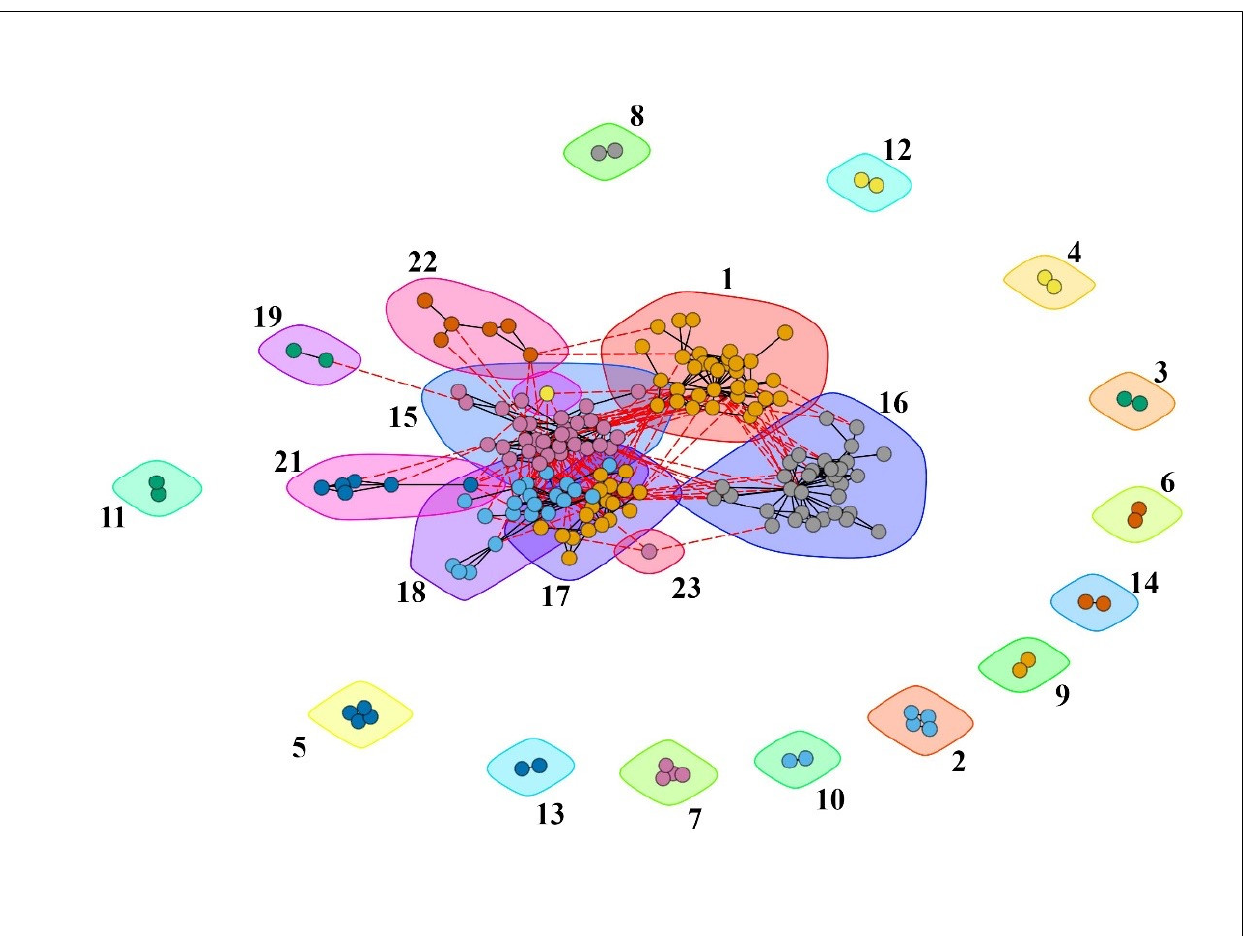
Figure 4. Collaboration network among the 201 most productive authors. The names of the authors were omitted, because the main focus is on the structure of the network, where it is possible to see a clump of clusters and several small “satellite” clusters. The clusters of authors are highlighted by different coloured polygons. See Supplementary Materials Table S4 for the authors’